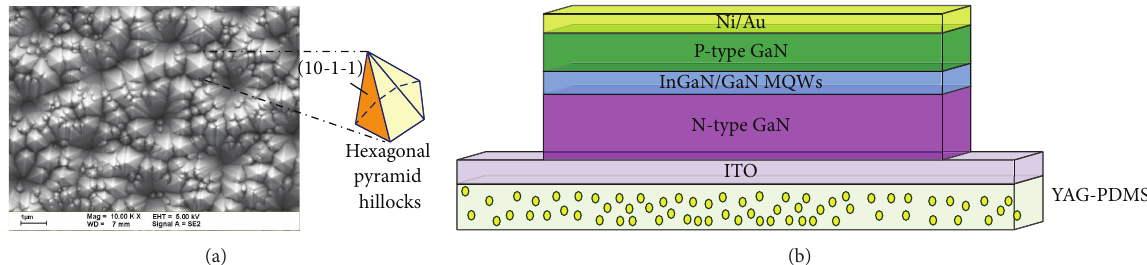
Figure 1: (a) Surface of the n-GaN epitaxial layer after KOH solution etching and (b) GaN-based LED after LLO process was mounted on flexible YAG-PDMS substrate.